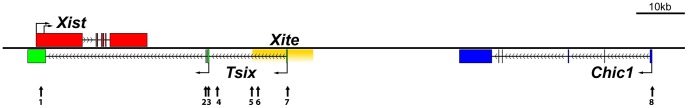
Map of selected elements within or surrounding the X-inactivation center region.The Xite (yellow) regulatory element is a positive enhancer of Tsix (green) expression, which is an antisense transcript that represses Xist (red). Numbers below arrows indicate regions amplified for DNA methylation studies. 1- Xist; 2-Tsix-CTCFc; 3- Tsix CGI, (major promoter); 4- Tsix (upstream major promoter); 5- Xite-DHS2; 6- Xite-DHS4, 7- Xite-DHS6 (Tsix minor promoter) and 8- Chic1 promoter.